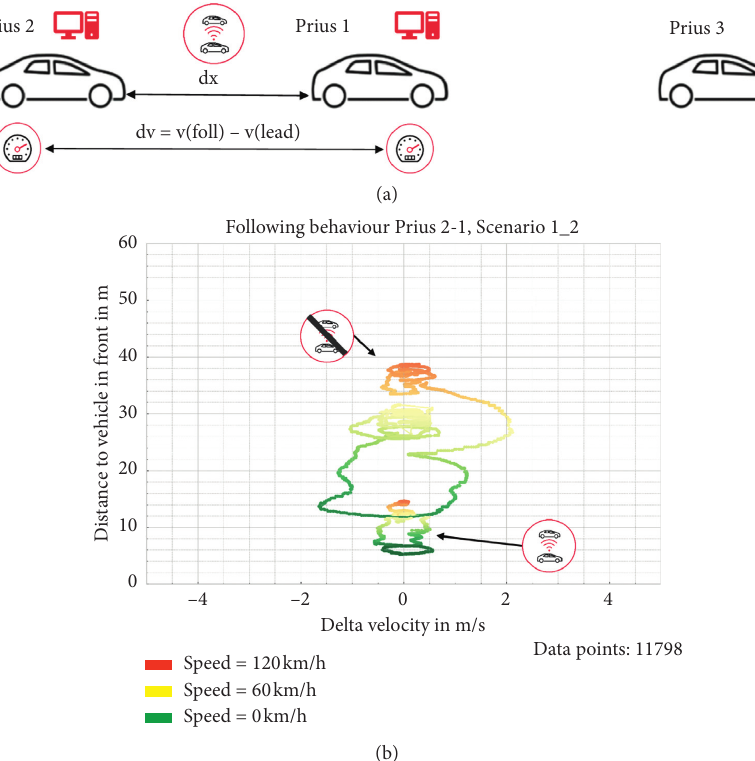
Figure 4: Relationship between speed difference and distance to preceding vehicle when